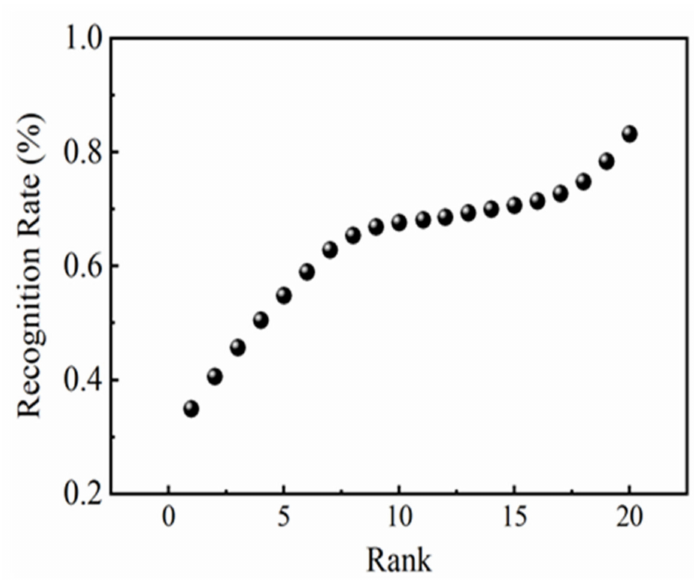
Figure 29. Cumulative matching characteristics (CMC)